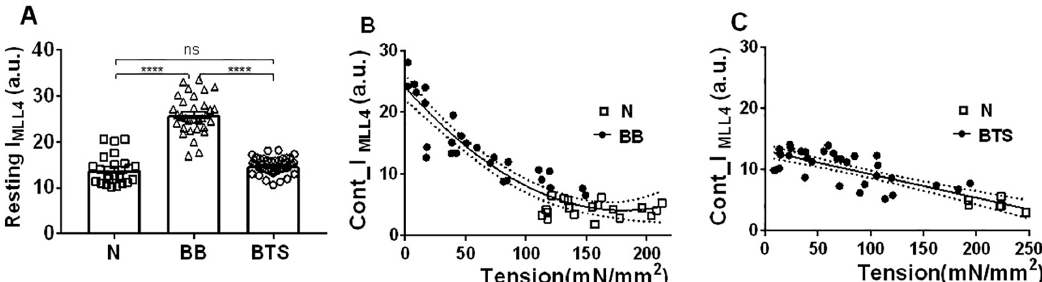
Figure 4. Myosin layer line 4 (MLL4) intensities (in arbitrary units–a.u.) in resting and contracting mouse EDL muscle. ( A ). The normalized MLL4 intensities were the same in untreated normal (N) muscle and BTS-treated muscle but the intensities almost doubled in samples after blebbistatin treatment (BB). ns: p ≥ 0.05; ****: p < 0.0001. ( B ) MLL4 intensities against tension generated by blebbistatin-treated (BB) and normal untreated (N) muscle. Line is the fit to a second order polynomial with R 2 = 0.87. Dotted lines show 95% confidence limits ( C ) MLL4 intensities against tension generated by BTS-treated and normal muscle. Solid line is the linear fit with R 2 = 0.68 and the dotted lines are 95% confidence limits. The slope of the line is significantly different from zero ( p < 0.0001).